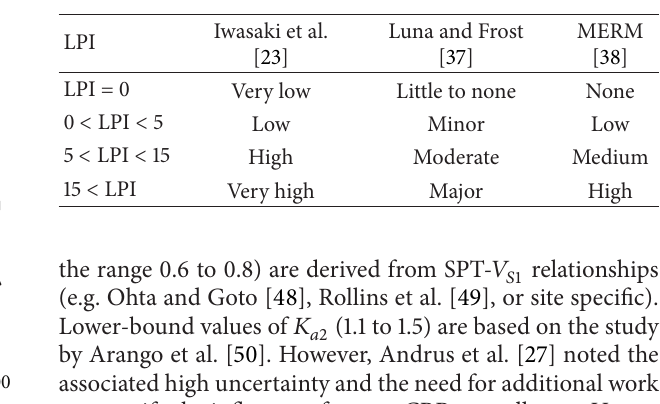
Table 4: The level of liquefaction